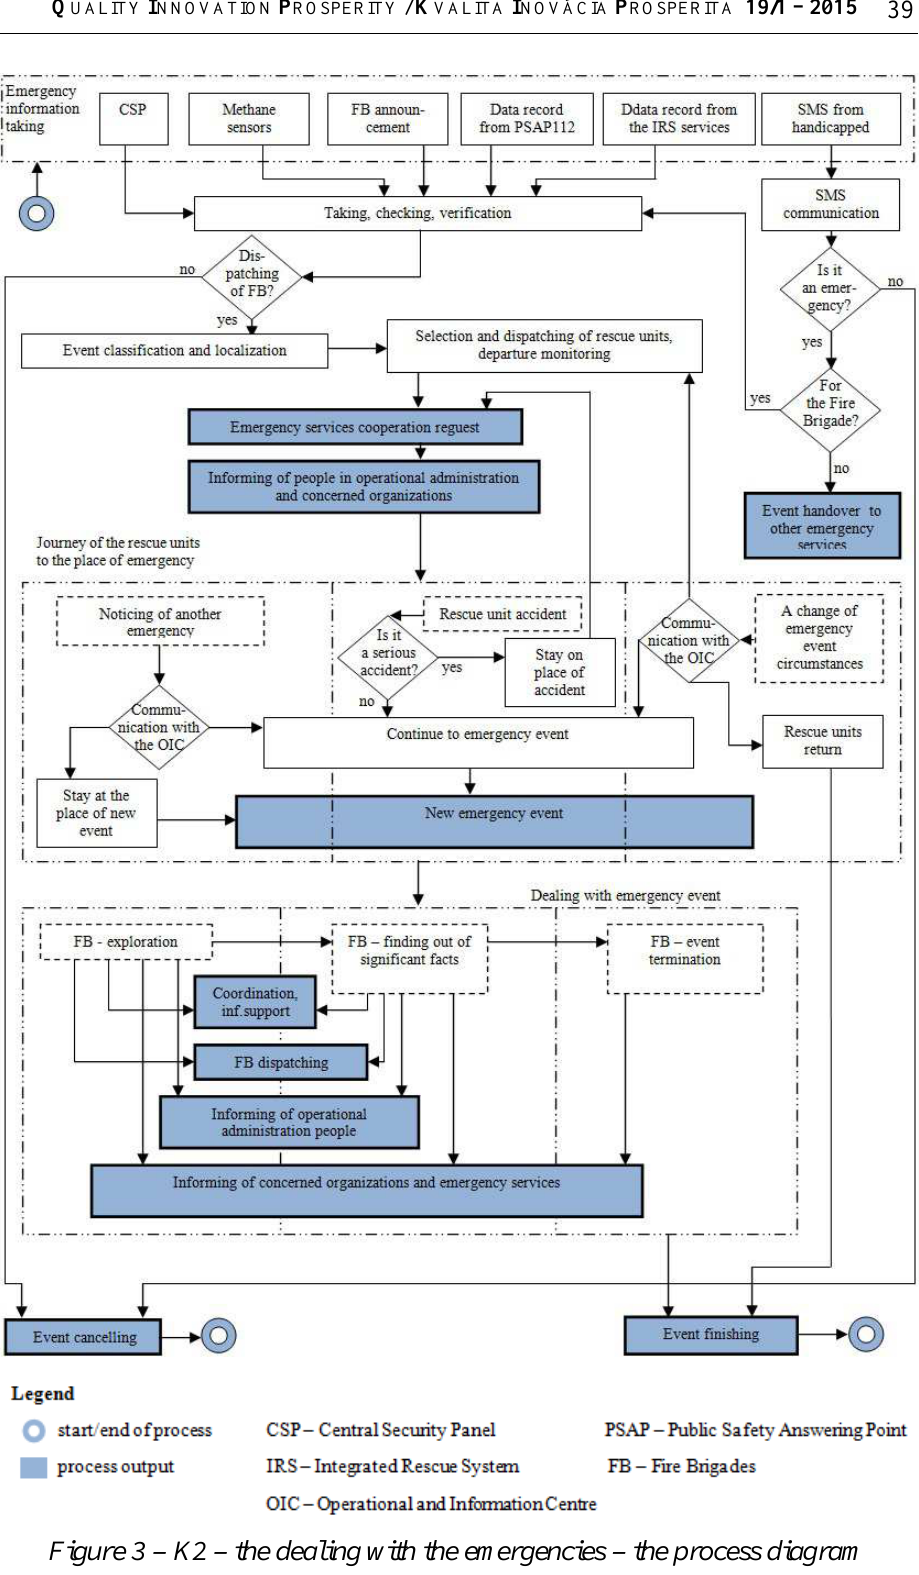
Figure 3 – K2 – the dealing with the emergencies – the process